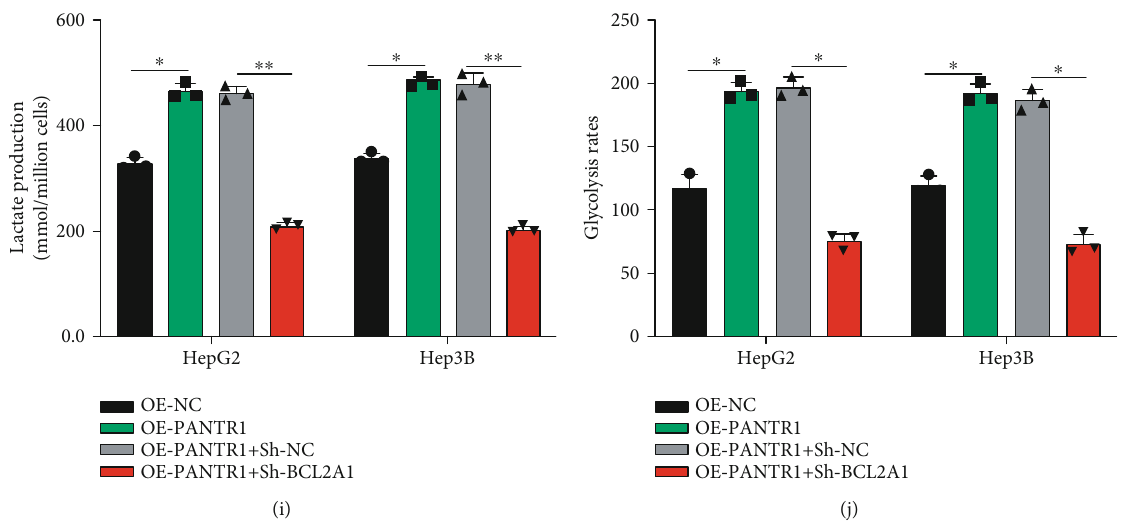
Figure 6: Identifying a novel lncRNA PANTR1/miR-587/BCL2A1 axis in HCC progression. (a) HepG2 and Hep3B cells were transfected with OE-NC, OE-PANTR1, OE-PANTR1+Sh-NC, and OE-PANTR1+Sh-BCL2A1 as indicated, and transfection e ffi ciencies were detected by qRT-PCR. (b, c) Cell proliferation abilities of pretreated HepG2 and Hep3B cells were detected by CCK-8 assays. (d, e) Flow cytometer assay was applied to evaluate the cell apoptosis rate of pretreated HepG2 and Hep3B cells. (f, g) Transwell migration assays were conducted to evaluate the migration level of pretreated HepG2 and Hep3B cells, and cell migration numbers were accounted. Comparative statistics are shown. Scale bars: 20 μ m. (h – j) The Warburg e ff ect phenomenon-related lactate production (h), glycolysis rates (i), and ATP levels (j) in HCC cells were measured. Data are shown as the mean ± standard deviation ( n = 3 ). ∗ P < 0 : 05 and ∗∗ P < 0 : 01 PANTR1 knockdown HCC cells (Figure 3(f)) ( ∗∗ P < 0 : 01 ).